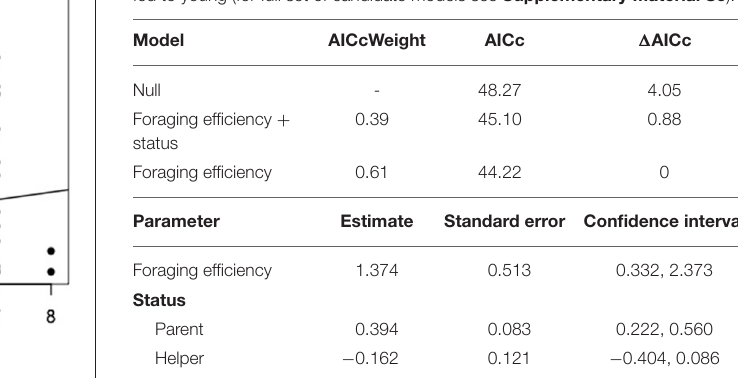
TABLE 3 | Top set of models for the factors influencing the amount of biomass fed to young (for full set of candidate models see Supplementary Material S5